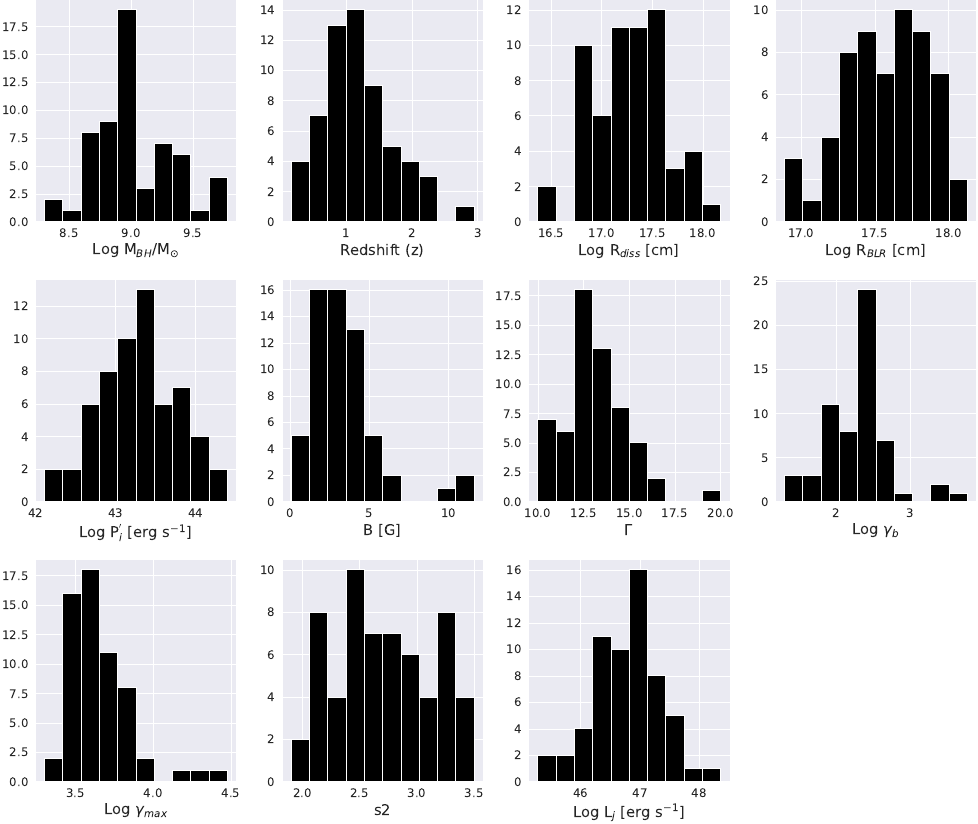
Figure 1. Distribution of best fit model parameters for reproducing the SED of 60 blazars. The data are taken from the literature published in